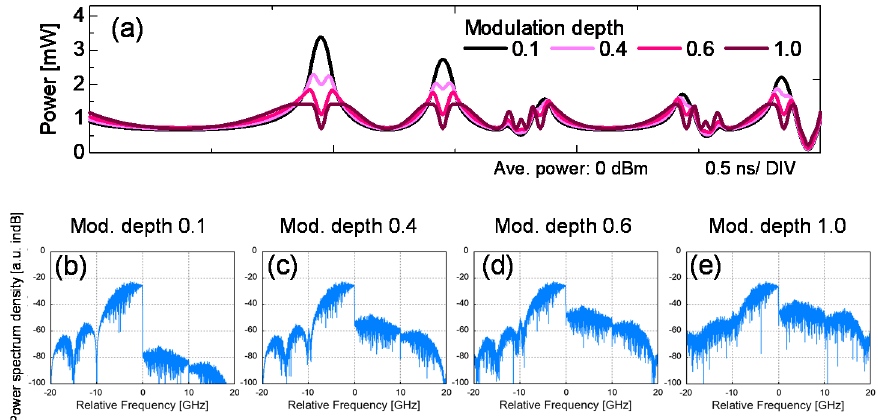
Figure 6. Peak clipped OSSB-SC signal ( V CL = V π ), ( a ) modulator output intensity waveform at modulation depths of 0.1, 0.4, 0.6 and 1.0, ( b – e ) power spectra of modulator output signals at modulation depths of 0.1, 0.4, 0.6 and 1.0